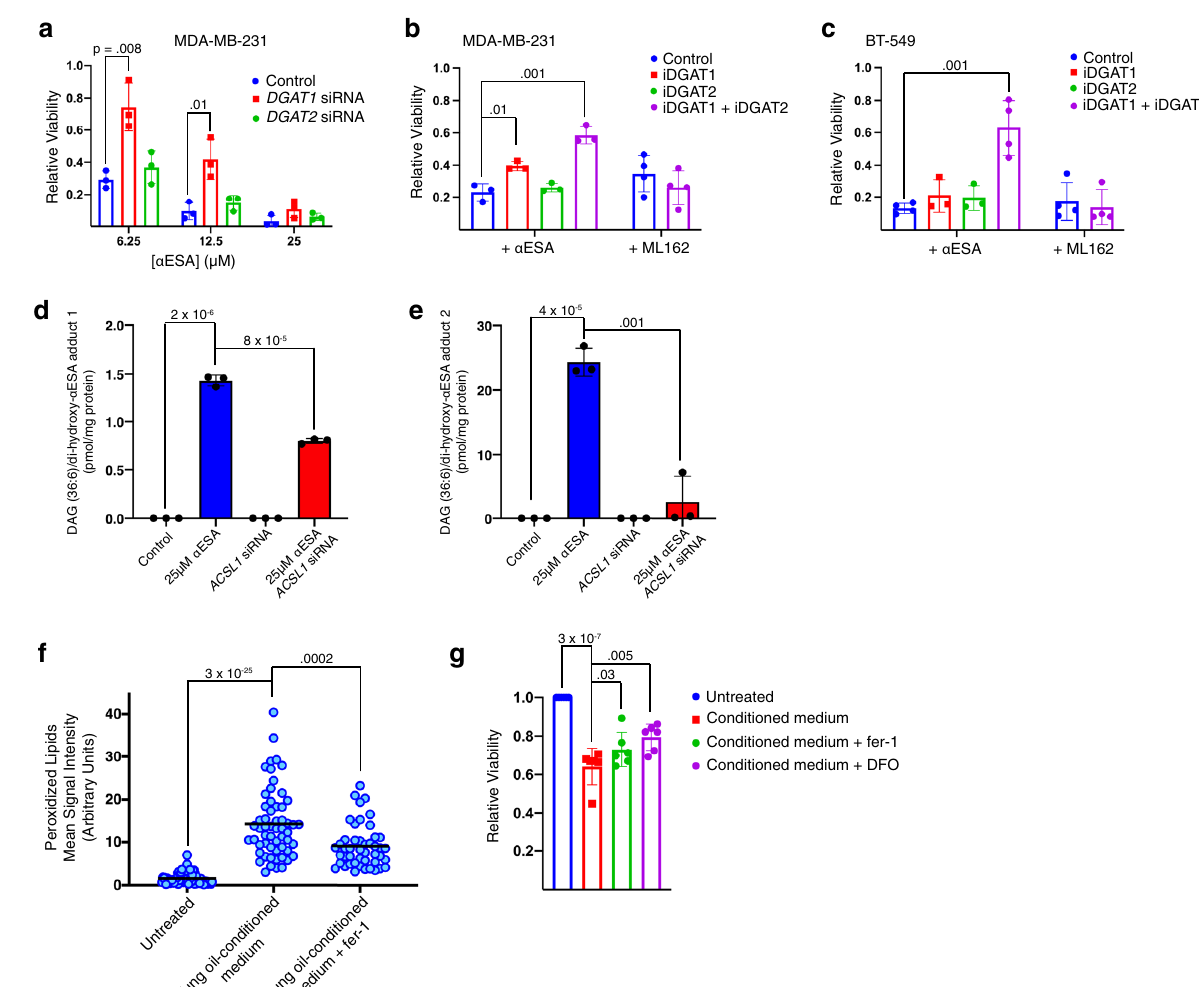
Fig. 8 Incorporation of α ESA into triacylglycerols promotes ferroptosis. a Relative viability of MDA-MB-231 cells 72 h after transfection with either DGAT1 -targeting, DGAT2 -targeting, or non-targeting siRNA followed by 24-hour treatment with indicated dose of α ESA ( n = 3 independent experiments). Error bars in this and subsequent panels show standard deviation centered on the mean, and p-values above comparator bars in this and subsequent panels are from two-sided Student ’ s t-tests unless noted. Bar charts showing the fraction of viable ( b ), MDA-MB-231 or ( c ), BT-549 cells incubated for 48 h with either 6.25 μ M α ESA ( n = 3 and 4 for MDA-MB-231 and BT-549, respectively) or 62.5 nM ML162 ( n = 4) and either vehicle, a DGAT1 inhibitor (4 μ M PF- 04620110), a DGAT2 inhibitor (4 μ M PF-06424439), or both inhibitors. d , e Bar charts showing the amount of two DAG (18:3/18:3)/dihydroxy α ESA adducts that were detected following treatment with α ESA and were signi fi cantly decreased by ACSL1 depletion ( n = 3 biological replicates). The m/z of adduct 1 and adduct 2 are 940.7278 and 942.7439, respectively. f Quantitation of lipid peroxidation products in individual BT-549 cells after being cultured for 2 h with normal medium, tung oil-conditioned medium, or tung oil-conditioned medium containing 2 μ M fer-1. The line indicates the mean. From left to right, n = 71, 57, and 46. g Bar charts showing relative cell viability for BT-549 cells cultured in normal growth medium or tung oil-conditioned medium with or without 2 μ M fer-1 or 50 μ M DFO ( n = 6 independent experiments). The values above the comparator bars represent the p-values from one-sided Student ’ s t-tests. Source data are provided as a Source Data fi this inhibitor combination (Fig. 8b, c) indicating a role for TAGs speci fi cally in α ESA-induced ferroptosis. Knockdown of adipose triglyceride lipase (ATGL; Supplementary Fig. 6c), which liberates fatty acids from TAGs, suppressed the toxicity of ML162 but not α ESA in two cell lines (Supplementary Fig. 6d – g). Atglistatin, a DAG containing two α ESA-derived chains (Fig. 8d, e). These pharmacological inhibitor of ATGL, in contrast, suppressed both α ESA and ML162 toxicity (Supplementary Fig. 6h – j), suggesting the possibility that atglistatin might act as a direct radical trap- ping agent as has been observed for other small molecule inhibitors 42 . Fatty acids and TAGs with conjugated double bonds undergo complex and poorly understood oxidative reactions distinct from that of unsaturated chains with non-conjugated double bonds 43 – 47 . Products of conjugated acyl chain oxidation include